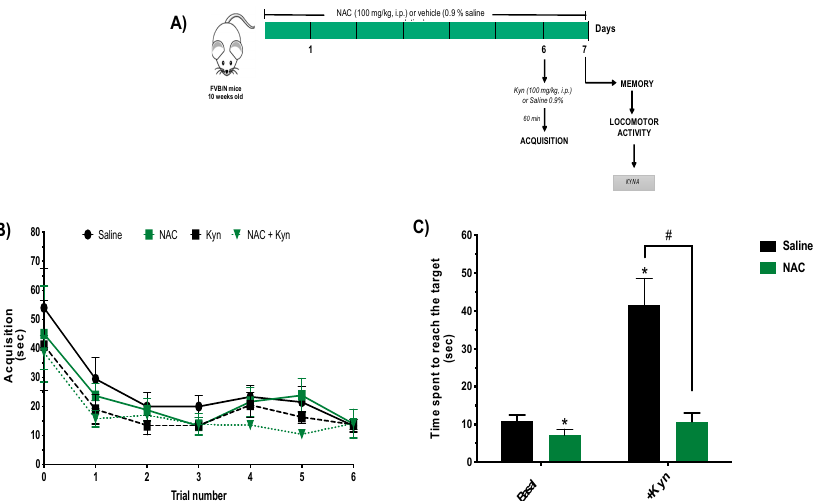
Figure 4. Subchronic NAC administration improves memory in the buried food location test. ( A ) Schematic illustration of the experimental protocol memory procedure. Memory and locomotor activity were examined after the subchronic administration of NAC (100 mg/kg/day) or saline. Two groups of animals received an additional acute i.p. injection of Kyn (100 mg/kg) or saline before acquisition of spatial learning on Day 6. See Materials and Methods for experimental details. ( B ) Acquisition (training) on Day 6. ( C ) Memory performance on Day 7. Data are the mean ± SEM ( n = 5 per group). Two-way ANOVA was performed for memory with pairwise comparisons using Tukey’s adjusted p -values: * p < 0.05 vs. saline and # p < 0.05 vs. Kyn.